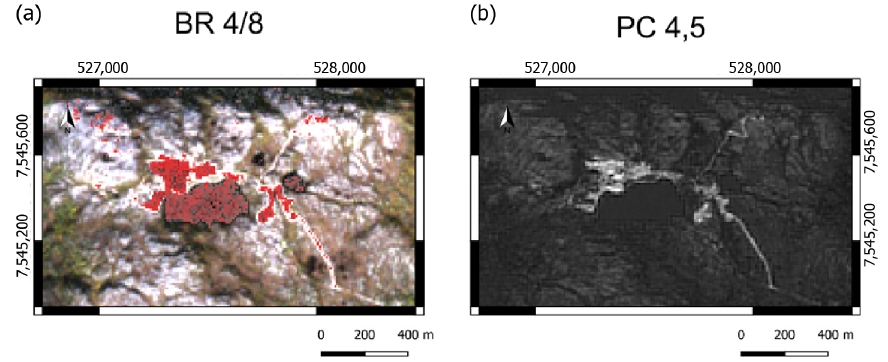
Figure 22. Comparison of the best BR and PCA results with the Håkonhals mine in focus. ( a ) BR 4/8. It is possible to see that the ratio also highlights water bodies and granite. ( b ) PCA of bands 4, 5. Note that it identifies the target area perfectly with no signal confusion with water or granite.